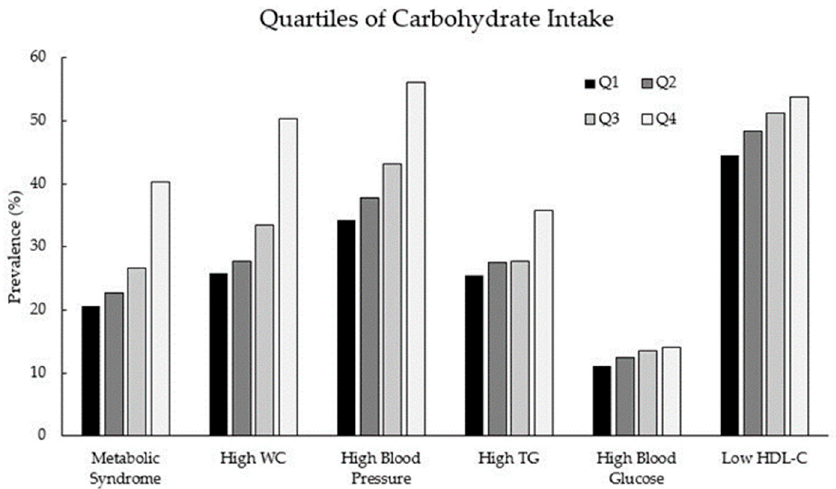
Figure 1. Prevalence of metabolic syndrome and its components according to the quartiles of carbohydrate intake. Q, quartile; TG, triglycerides; HDL-C, high-density lipoprotein/cholesterol; WC, waist circumference.